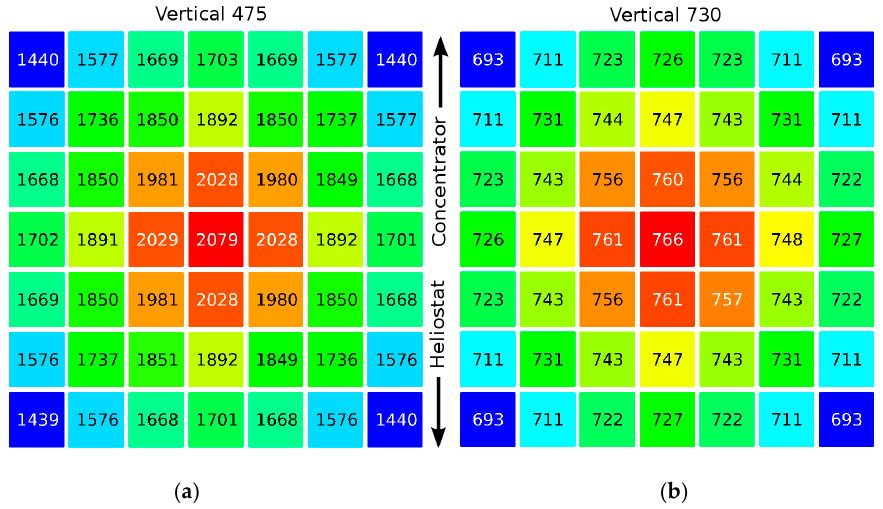
Figure 7. Energy flux (in kW/m 2 ) calculated for a vertical beam, for planes z = 475 mm ( a ) and z = 730 mm ( b ) below the concentrator axis (shifted 90 mm below), using a relative colour scale, from blue (cold) to red (hot). The x axis is horizontal. The vertical y direction is aligned with the paraboloid axis, pointing above (+y) to the paraboloid concentrator, and below (-y) to the heliostat.